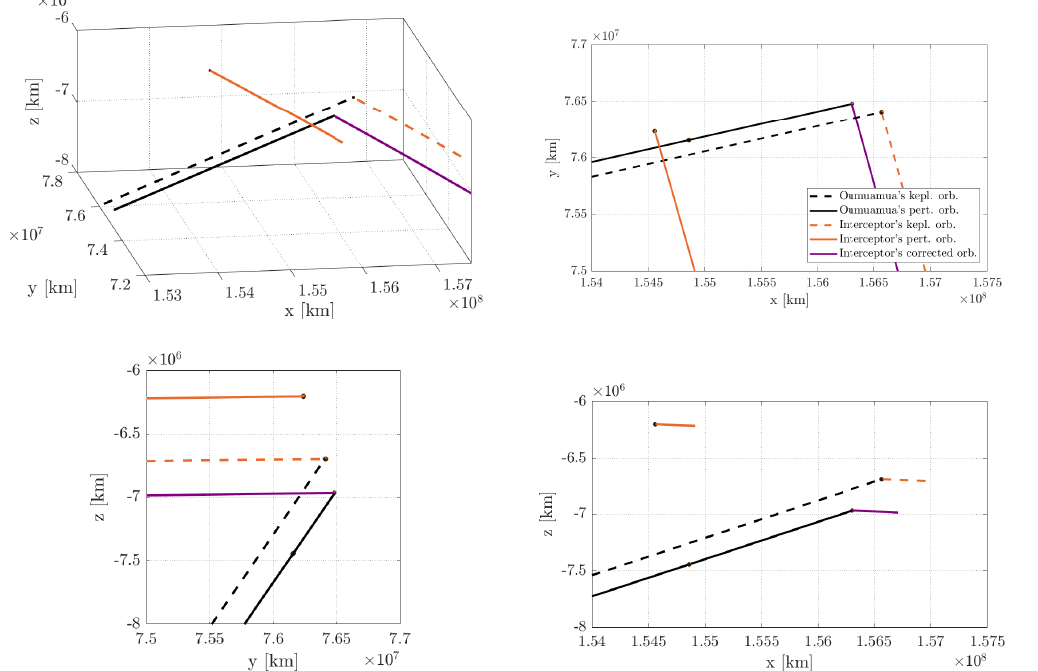
Figure 11. Trajectories of the ’Oumuamua (black), interceptor with initial impulse (orange) and interceptor with corrected impulse (purple) without perturbations (dashed line) and when adding the considered perturbations (solid line). All units are given in